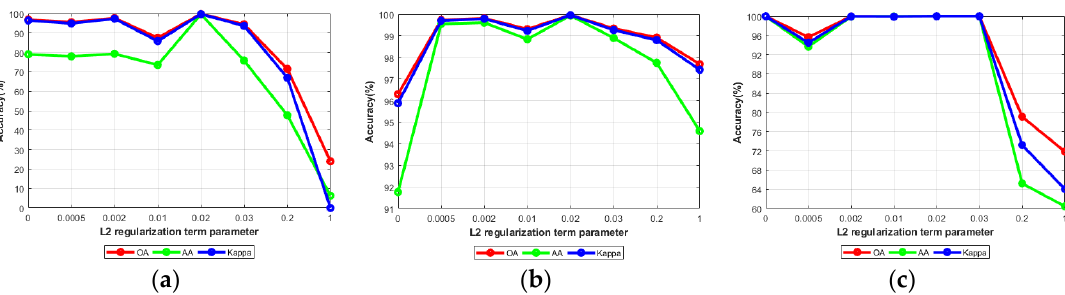
Figure 16. The influence of L2 regularization parameter. ( a – c ) represent the influence of L2 regularization parameter λ on IN, KSC and SA,